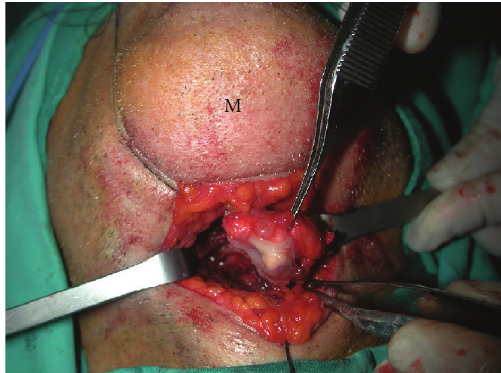
Figure 2: En bloc excision of well-circumscribed mass in the tongue base. M: